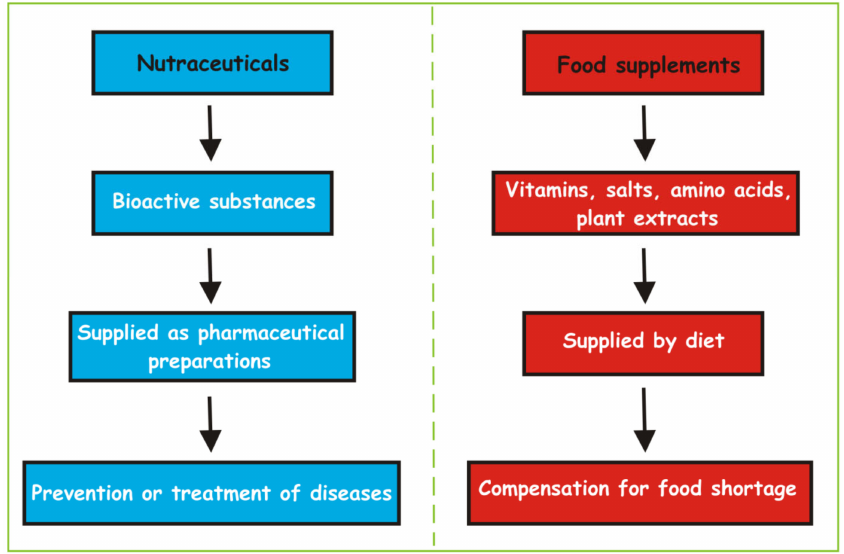
Figure 1. The main and substantial di ff erences between nutraceuticals and food